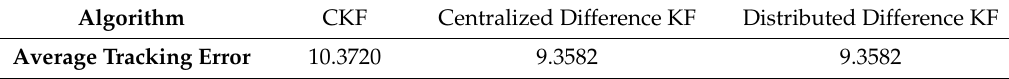
Figure 3. Comparison of the three algorithms in multisensor case. Table 4. The average tracking errors of the three methods.